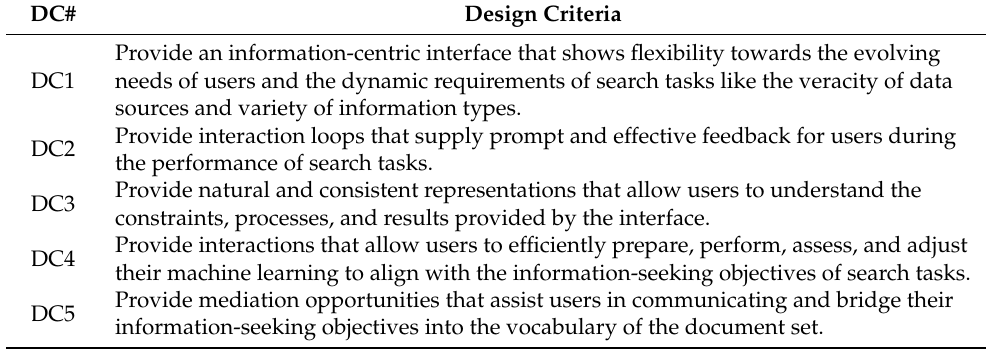
Table 1. The criteria for guiding the design of interfaces for health informatics search tasks involving large document sets. For abbreviation purposes, design criteria will be referenced in the text as DC#, where # is its assigned